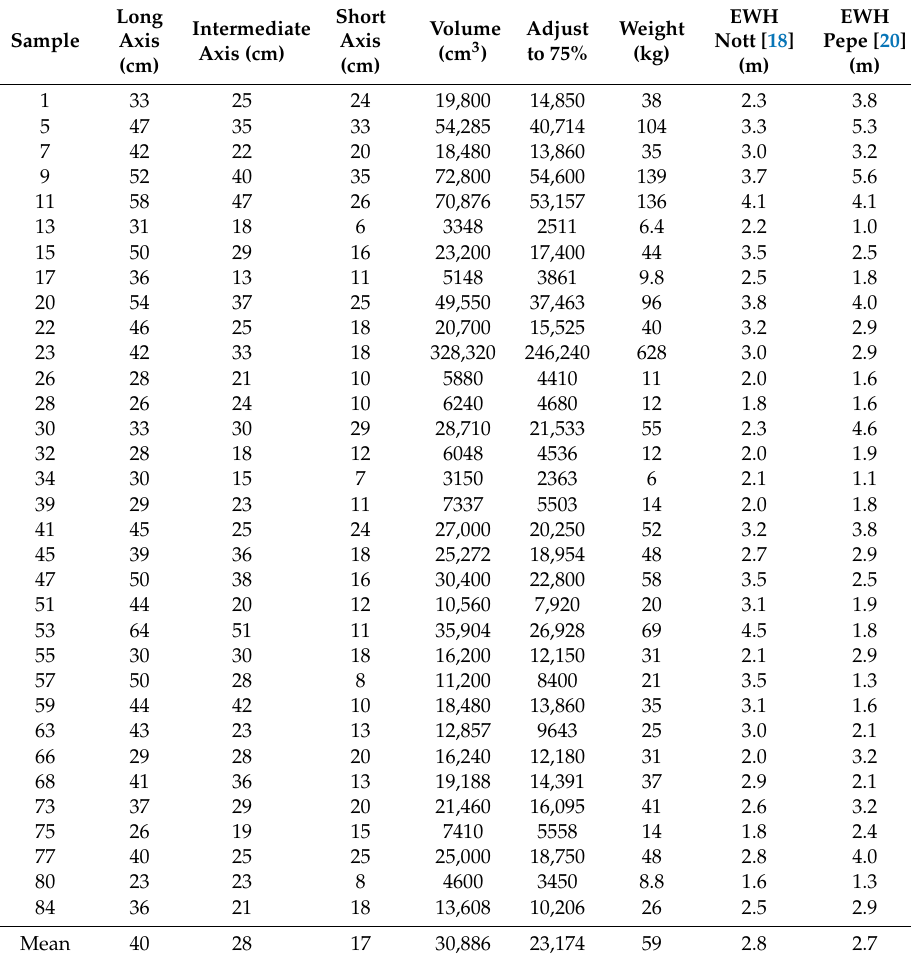
Table A2. Quantification of boulder size, volume, and estimated weight from selected coastal bar samples through transect 2 at Bah í a San Luis Gonzaga. EWH = estimated wave height. The density of Baja Californian andesite at 2.3 gm / cm 2 is applied uniformly in order to calculate wave height for each boulder.